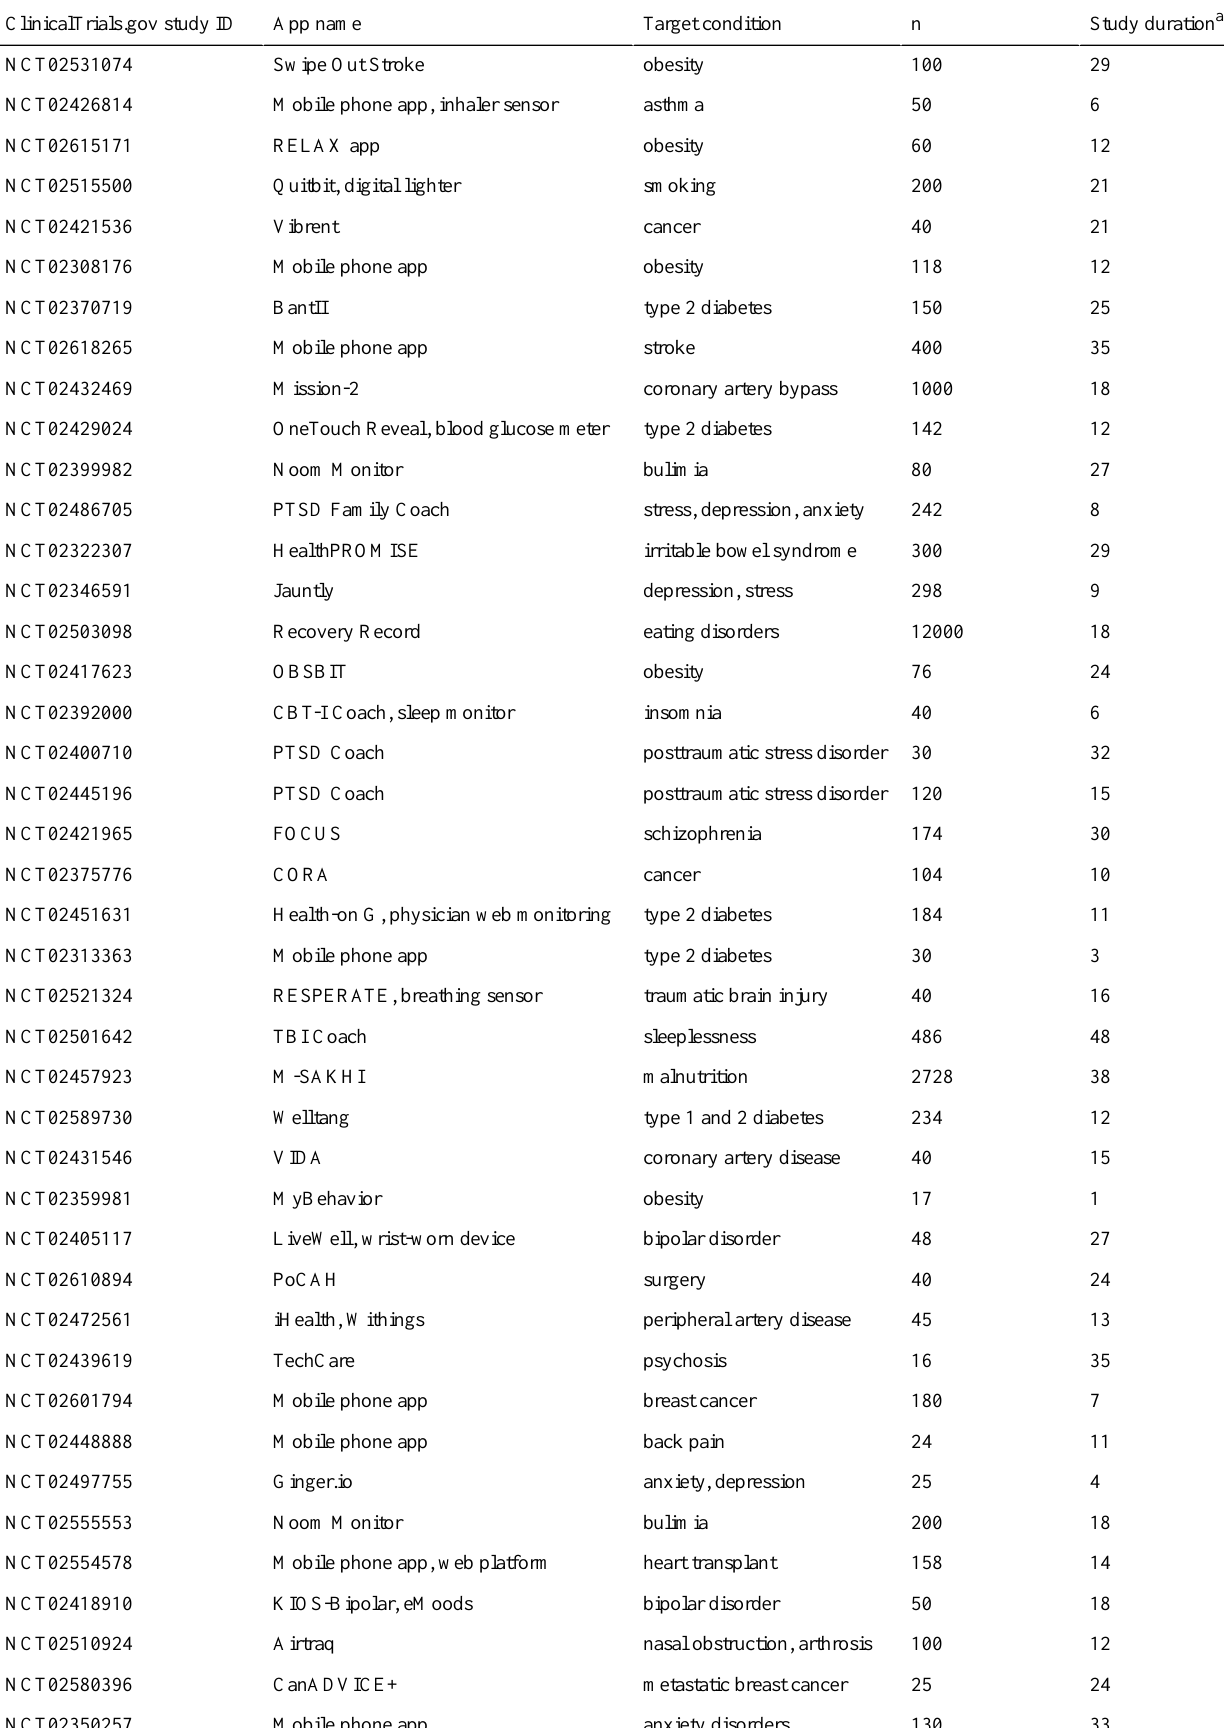
Table 2. General characteristics of reviewed trials registered on